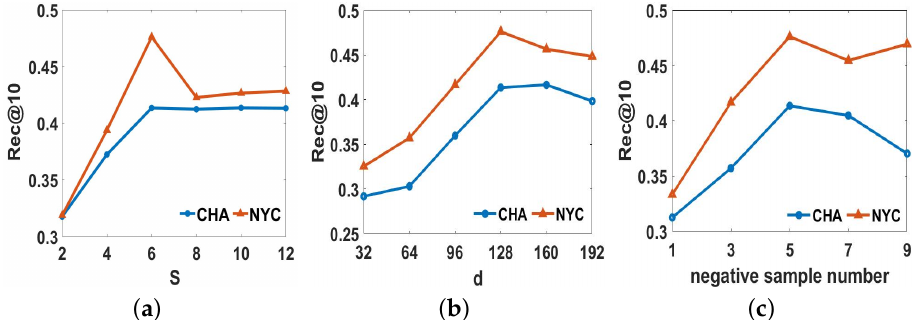
Figure 5. Performance of different hyper-parameters on the CHA and NYC datasets in LSMA. ( a ) different sequence length S ; ( b ) different embedding dimension d ; ( c ) different number of nega- tive samples.